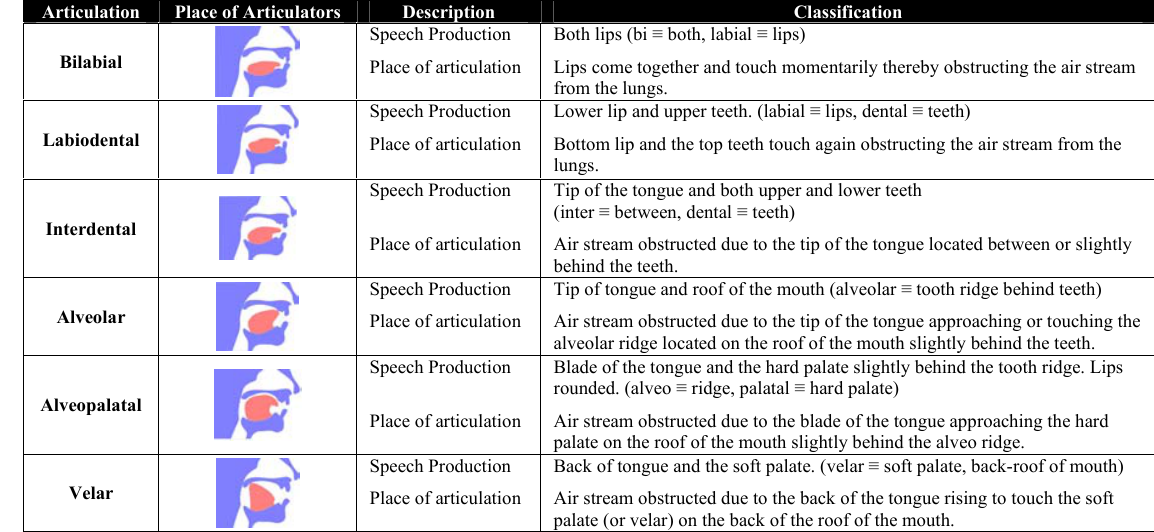
Table 10: Place of Articulation of Sindhi Consonant Phonemes Articulation